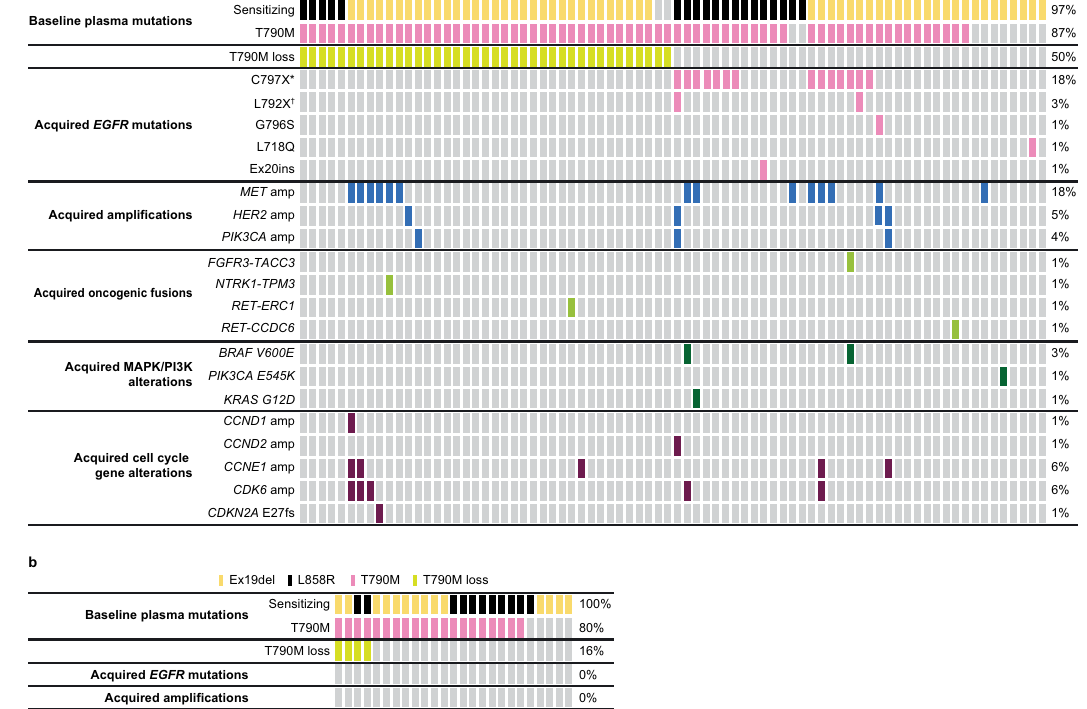
treated patients ( n =25) from the AURA3 trial. Source data are provided in the Supplementary Data 1 fi le. *C797S or C797G; † L792F or L792H. EGFR epidermal growth factor